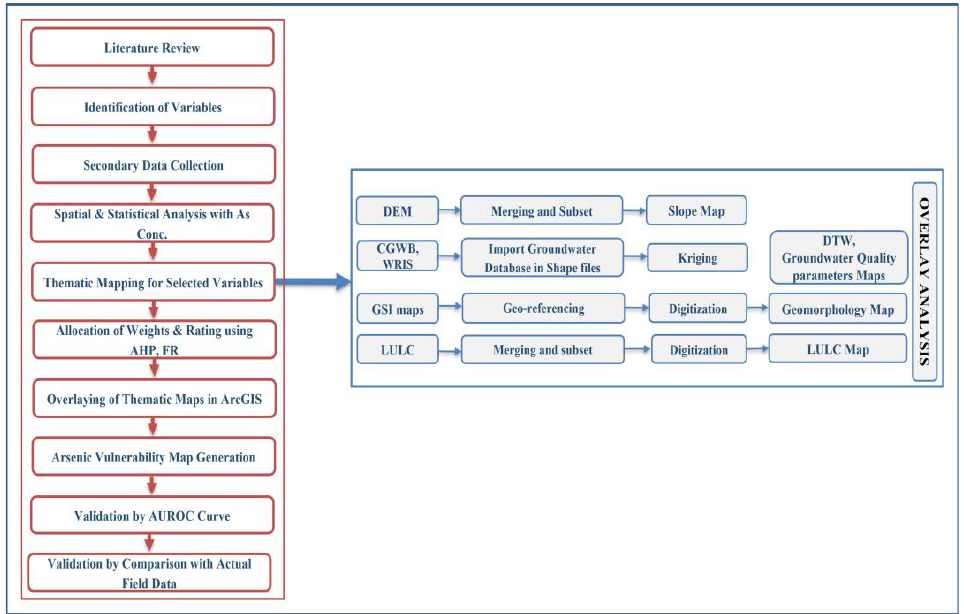
Figure 2. Schematic flowchart of the methodology of arsenic occurrence, assessment, and mapping.